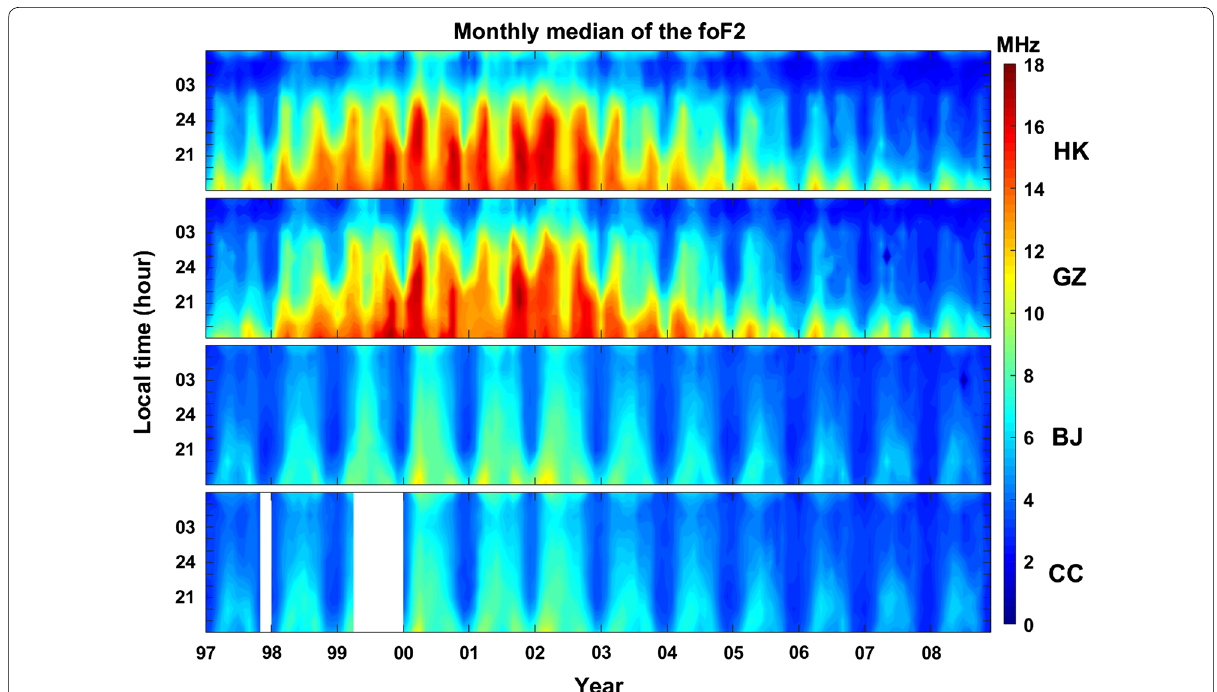
Fig. 8 Variation of the monthly median foF2 at the four sites between 1997 and